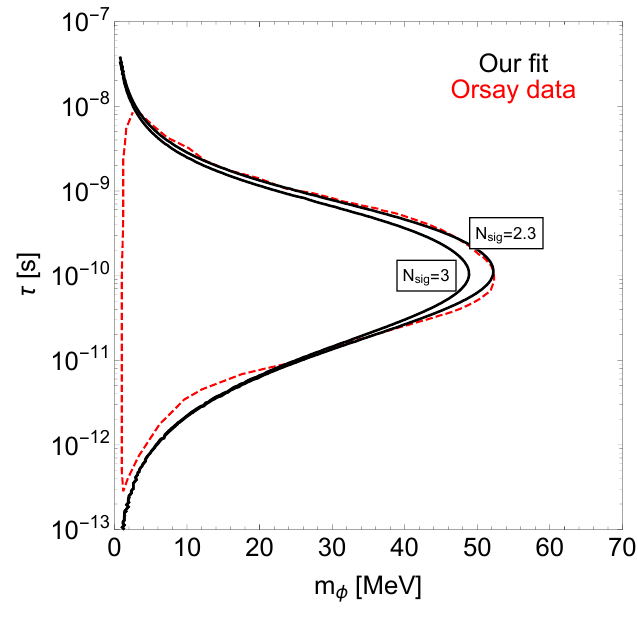
Figure 5 . The numerical (cid:12)t to Orsay